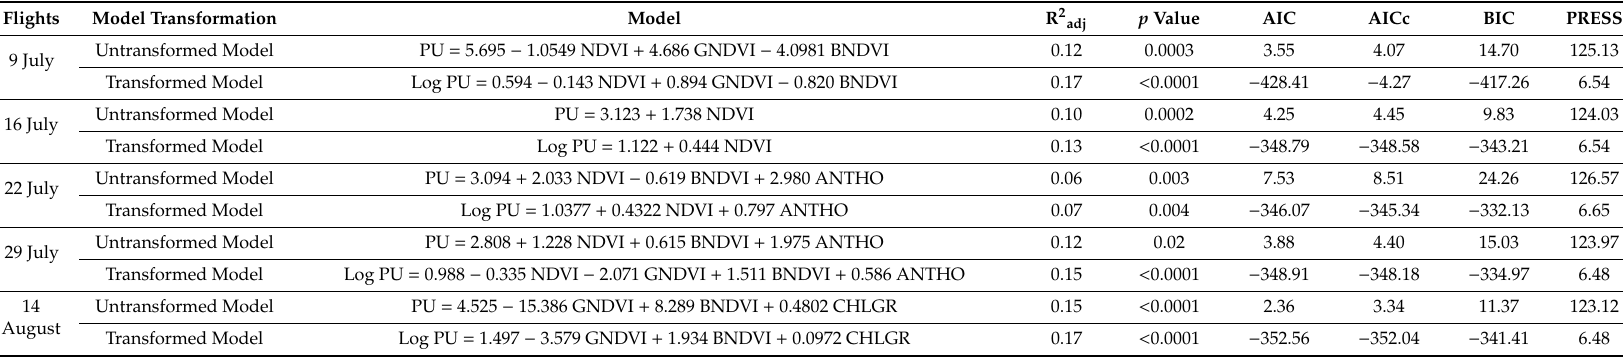
Table 9. Phosphorus uptake (kg ha − 1 ) models with the adjusted coe ffi cient of determination (R 2 adj ), p Value, AIC, AICc, BIC, and PRESS for flight operations. Flights Model